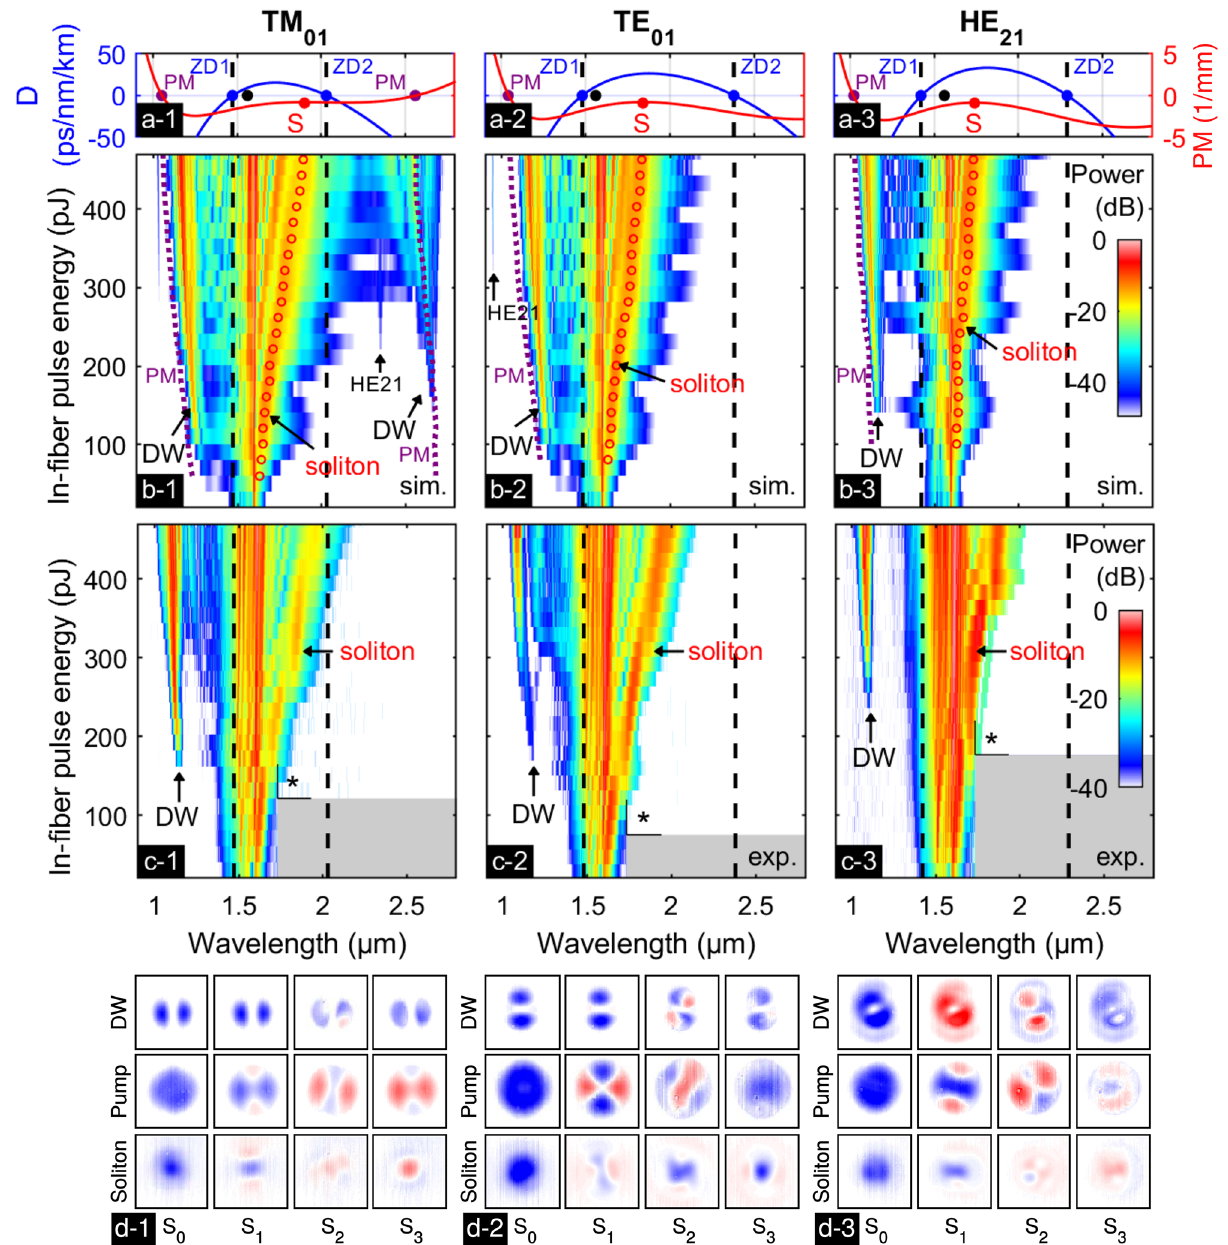
Figure 3. Supercontinuum generation inside a CS 2 -LCF (core diameter Ø core = 3.9 µm) in case of TM 01 - (column 1), TE 01 - (column 2) and HE 21 -like excitation (column 3). Row ( a ): spectral distribution of the group velocity dispersion parameter D , with ZDWs (ZD1 and ZD2) marked as black dashed lines. The pump wavelength λ P is shown as black dot. The phase-mismatch (PM) is given in red (right axis) for the highest in-fiber energy (483pJ) using the corresponding soliton wavelength S and Eq. (1). The resulting phase-matched wavelengths are marked with PM. Row ( b ): corresponding normalized nonlinear pulse evolution simulations including intermodal coupling. The energy-dependent phase-matching wavelengths (purple dotted lines) are calculated for the respective soliton wavelengths (red circles). The input power distribution across the different modes is as follows: ( b-1 ) 99% TM 01 , 1% HE 21 , ( b-2 ) 96% TE 01 , 3% TM 01 , 1% HE 21 , ( b-3 ) 100% HE 21 . The plots show the accumulated power in all simultaneously injected modes. Row ( c ): measured normalized spectral evolutions for increasing in-fiber pulse energy. The asterisk (*) marks the start of the spectra with reduced dynamic range, detected with a less sensitive spectrometer, whose noise floor was reduced artificially. No experimental data is available in the gray shaded regions. The colorbar at the right corresponds to all measured spectra. Row ( d ): measured spatial distribution of the Stokes parameters at an input pulse energy of ≈ 400 pJ in the spectral intervals of the three main spectral features (top row: dispersive wave (DW), center row: pump, bottom row: soliton.) The blue (red) color indicates a value of 1